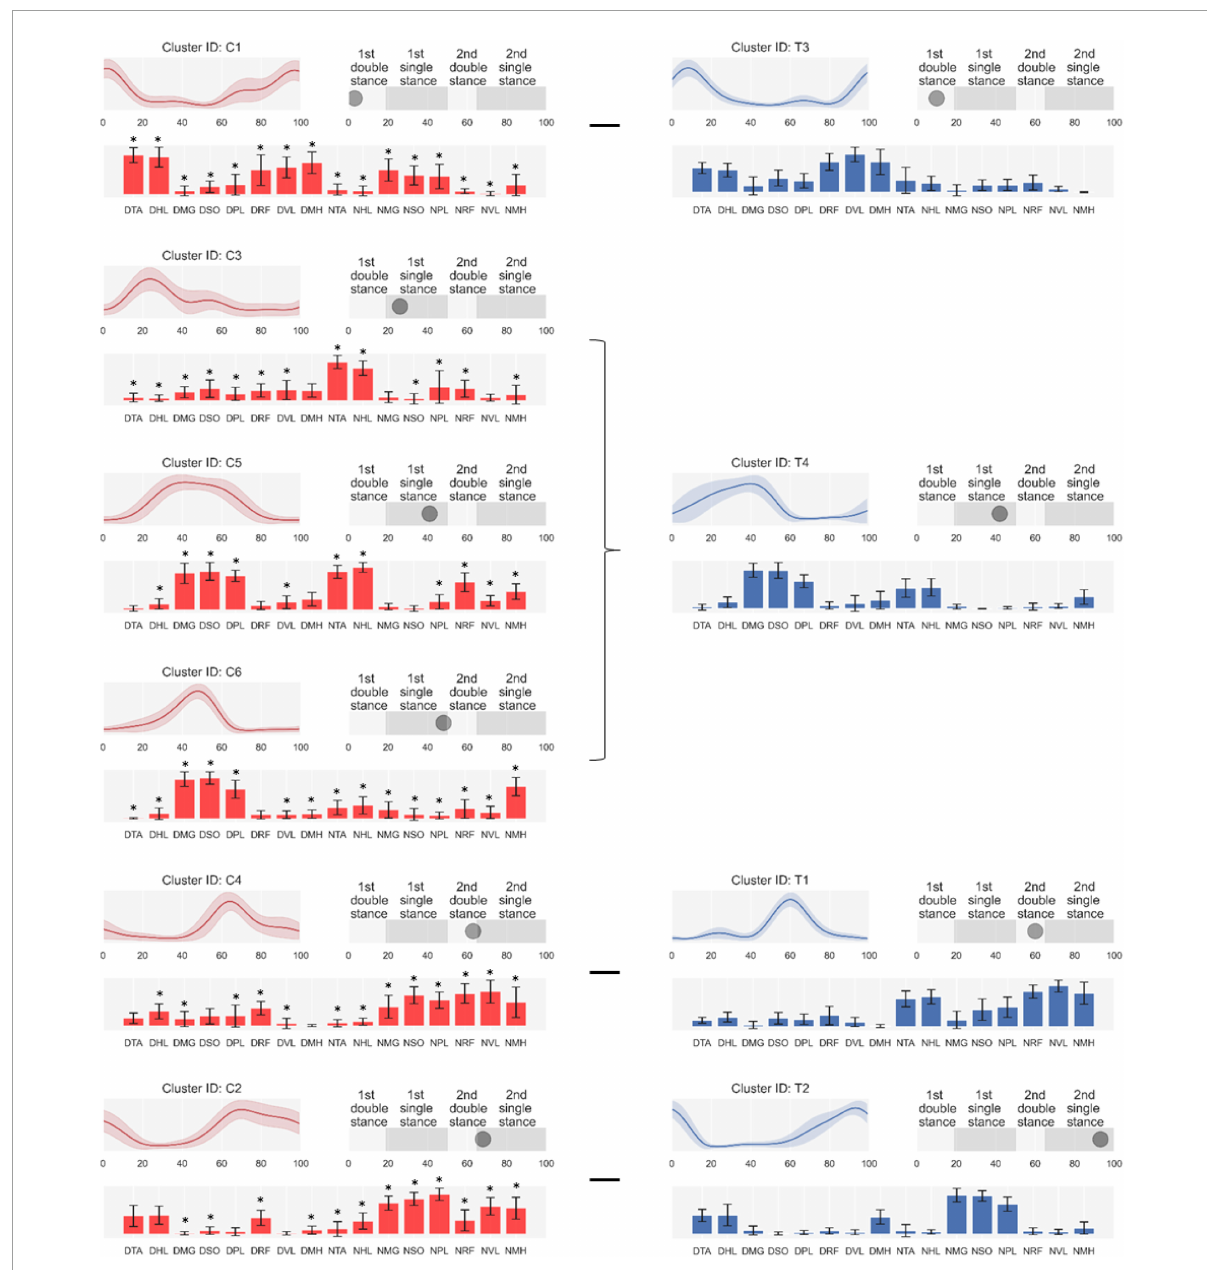
FIGURE3 Synergy activations (top left), structures (low), and peak activation time in the gait cycle (top right). Cluster-ID is displayed above each subfigure (C, cerebral palsy; T, typical development). The left column consists of clusters specialized for cerebral palsy, and the right one is for typical development. Subfigures are arranged based on peak activation time from top to bottom for each column. Data are expressed as mean and standard deviation. The labels of bar plots are combined with leg side and muscle names as follows: D, dominant leg; N, non-dominant leg; TA, tibialis anterior; EH, extensor hallucis longus; LG, lateral gastrocnemius; SO, soleus; RF, rectus femoris; VL, vastus lateralis; ST, semitendinosus; BF, biceps femoris. ∗ : Significant difference compared with the same muscle in children with typical development shown on the right of the figure (Scheffe’s test, p <